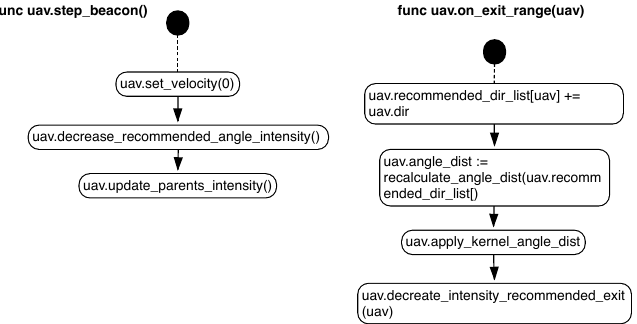
Figure 5. State diagram for the SLABE behavior of individuals of type repeater , also called beacon . For each processing step, any individual in this role will execute the steps listed by the